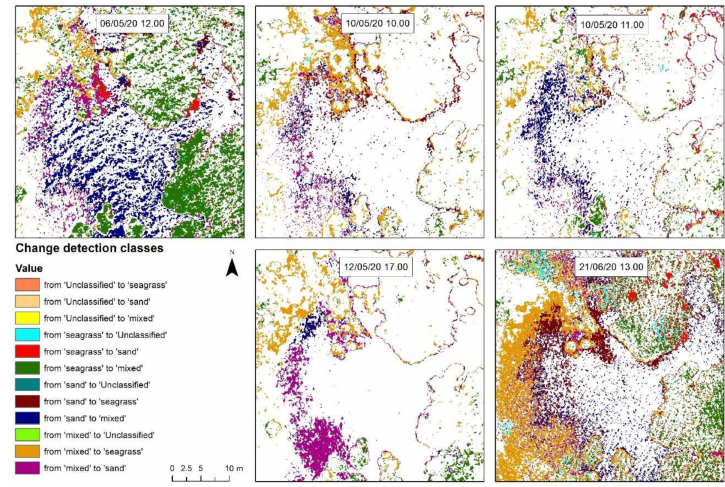
Figure 5. The change detection classes on the orthophoto-map subsets for each acquisition. The legend shows the changes (from class to class) that have been calculated from the change detection workflow, in different colours.